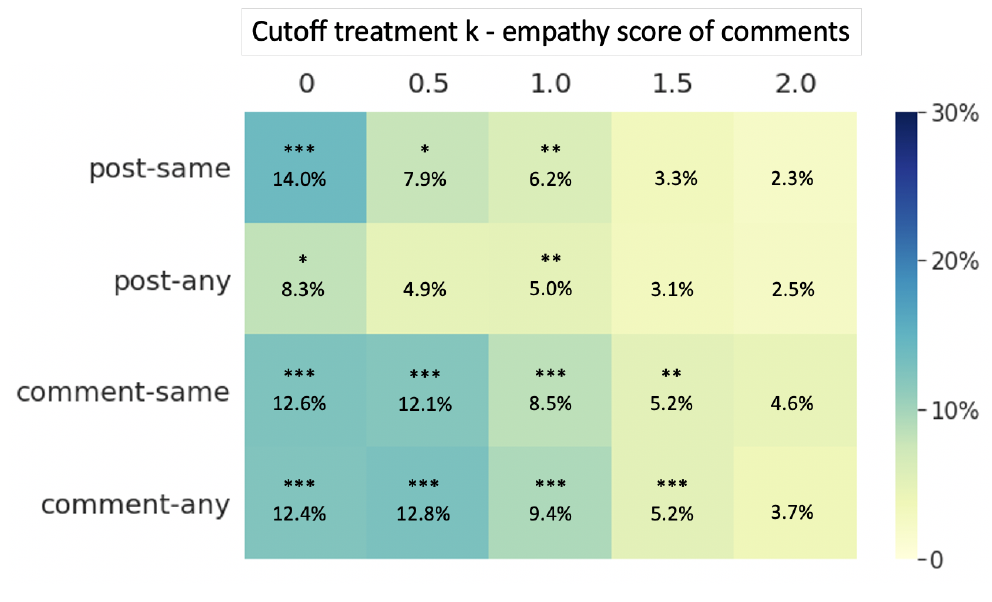
Figure 4. Effectsizeofthedifferenceinreturnprobabilitybetweenmoreempathicgroupandlessempathicgroup in different treatment definitions (more empathic group: average empathy score of received comments > k , less empathic group: average empathy score of received comments ≤ k ). * p < 0.05, ** p < 0.01, *** p <